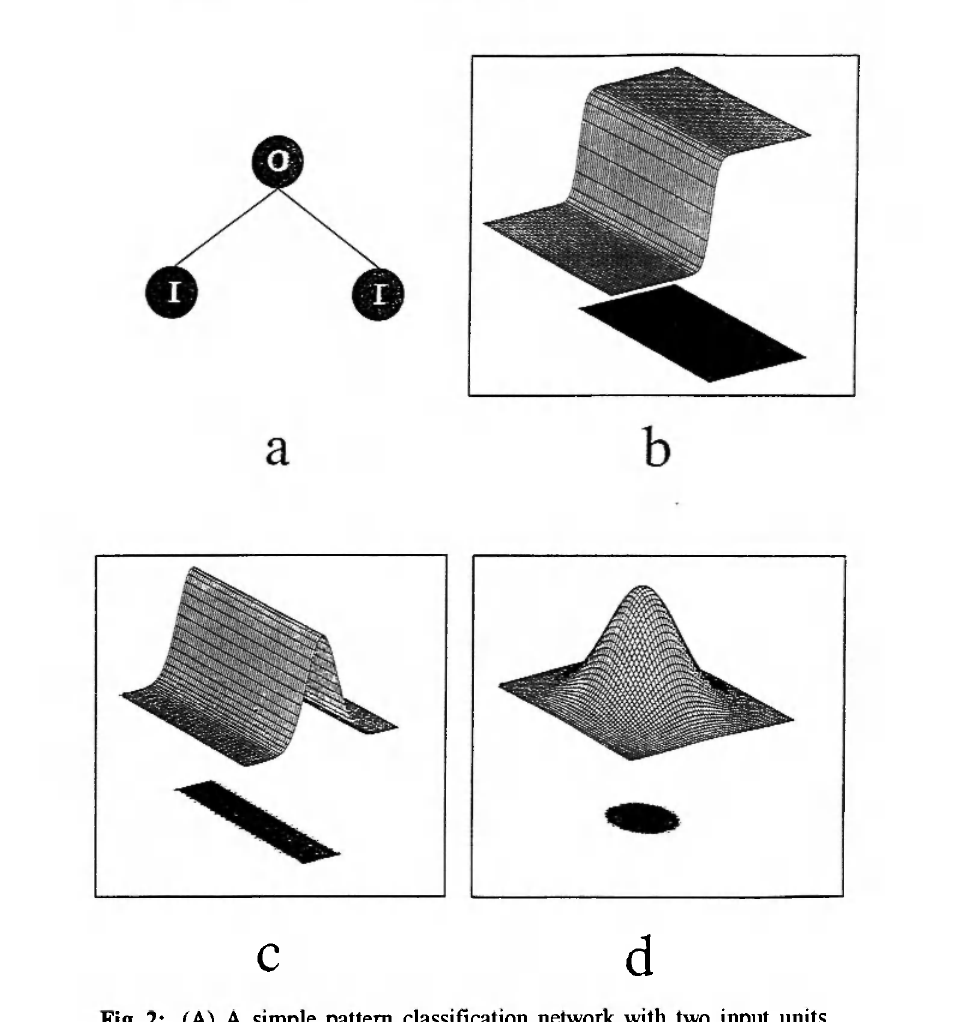
Fig. 2: (Α) Α simple pattern classification network with two input units and one output unit. Its "carving" of a two-dimensional pattern space depends upon the output unit's activation function. With a monotonic "squashing" function like the logistic (B), the network carves the pattern space into two regions with a single plane, as illustrated by the "shadow" cast by the network's receptive field. (C) With the Gaussian function used in Dawson and Schopflocher's (1992b) value units, the pattern space is carved into three regions by two parallel planes. (D) With the Gaussian function used in RBF networks, highly localized regions of the pattern space can be selected.